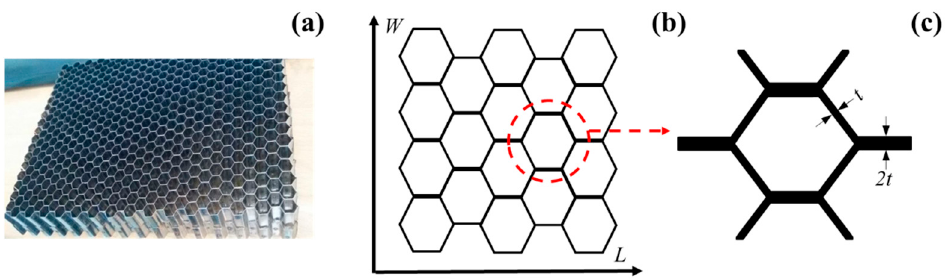
Figure 1. Ti-6Al-4V metal honeycomb core: ( a ) honeycomb core fabricated, ( b ) sketch diagram along the L and W directions and ( c ) cell unit.